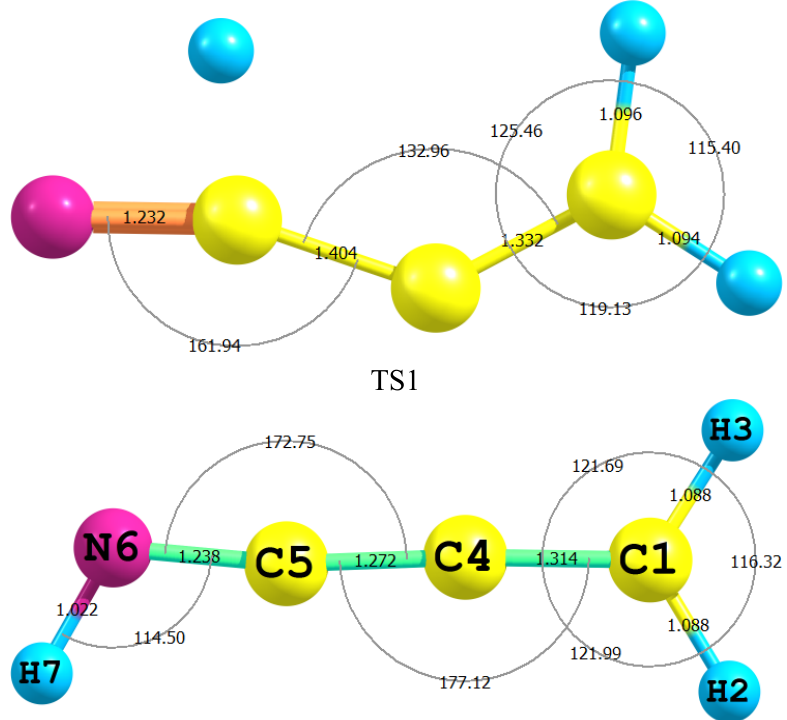
Figure 2. The numbering of atoms for the Intermediate (III) and Transition States (TS1 and TS2) together with their optimized bond lengths (Å) and angles (degrees) using B3LYP /aug-cc-pvdz level of